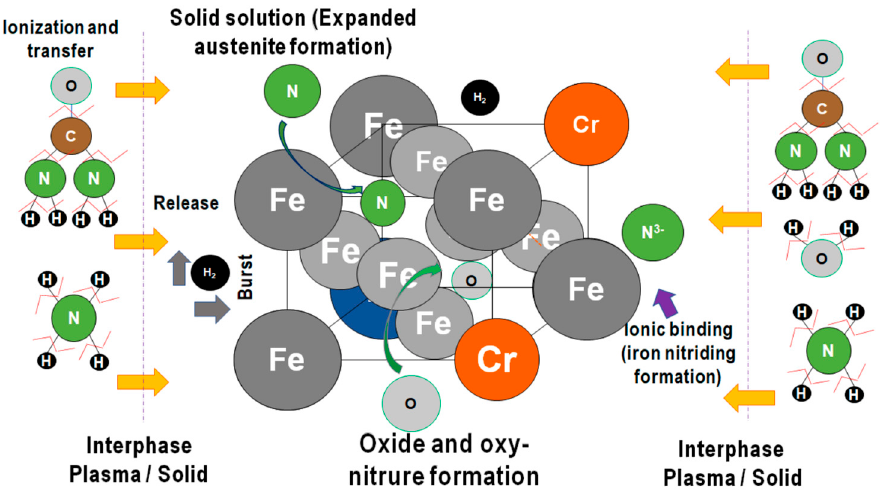
Figure 13. Transfer of reactive species towards the surface of the working electrode and its surface modification in the SSONPE process of AISI 304 SS.